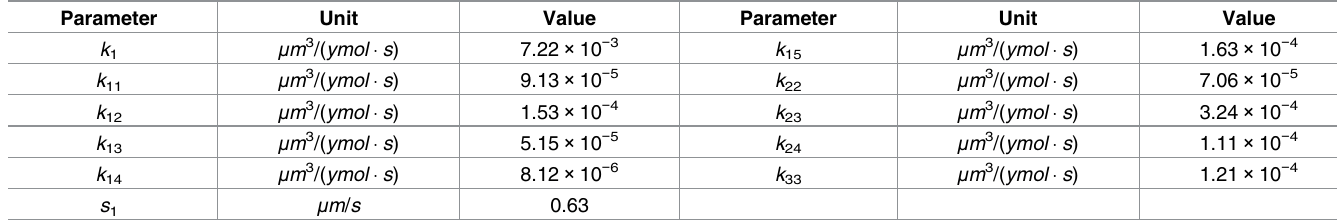
Table 5. Values of some parameters for Gag-dCTD.